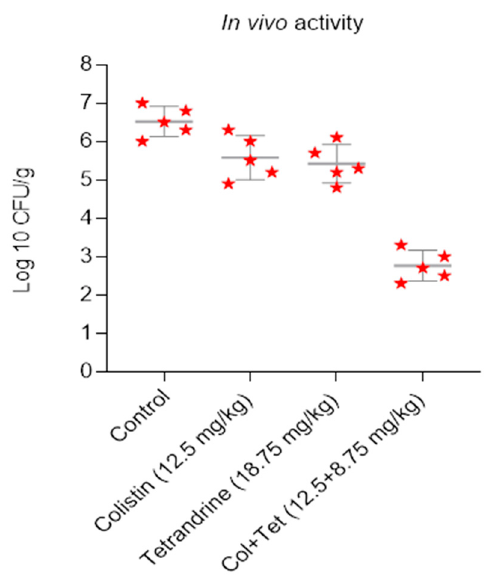
Figure 5. Colistin and tetrandrine together inhibit infection by colistin-resistant E. coli in neutropenic mice. In vivo activity of colistin and tetrandrine alone and in combination in neutropenic mice, infected with colistin-resistant E. coli , show that neither colistin nor tetrandrine alone inhibits the growth of E. coli , but treatment with colistin and tetrandrine in combination reduces the bacterial load.